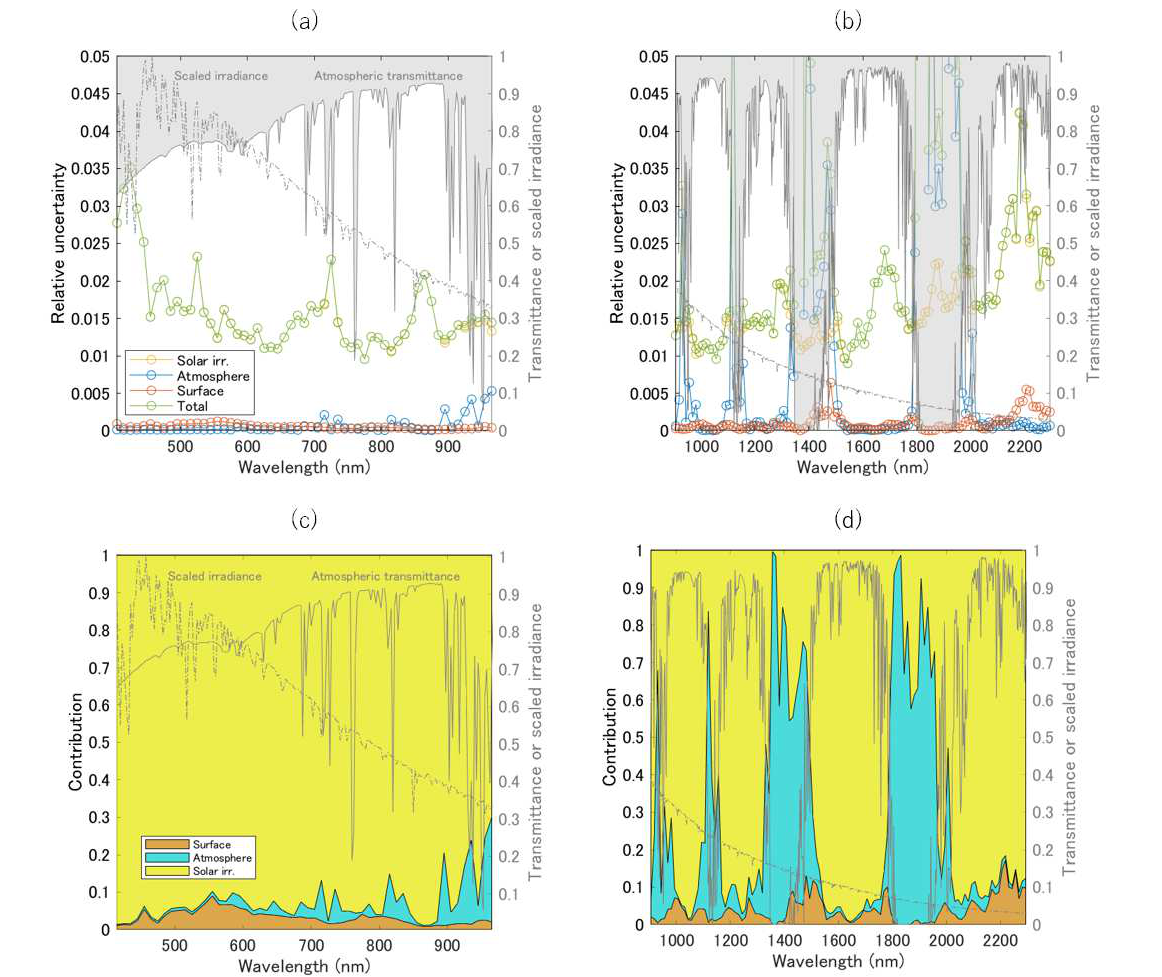
Figure 5. ( a ) Plot of the approximated uncertainties in the relative values from each layer (exo-atmosphere, atmosphere, and surface) and the total uncertainties in the approximations of the relative values for the HISUI VNIR band region at a higher standard deviation in the solar irradiance models (Case-2). ( b ) The same plot for the HISUI SWIR region ( < 2300 nm). ( c ) Plot of the relative contributions of the uncertainties in each layer to the total uncertainties in the VNIR region for Case-2 of the solar irradiance model. ( d ) The same plot for the SWIR region ( < 2300